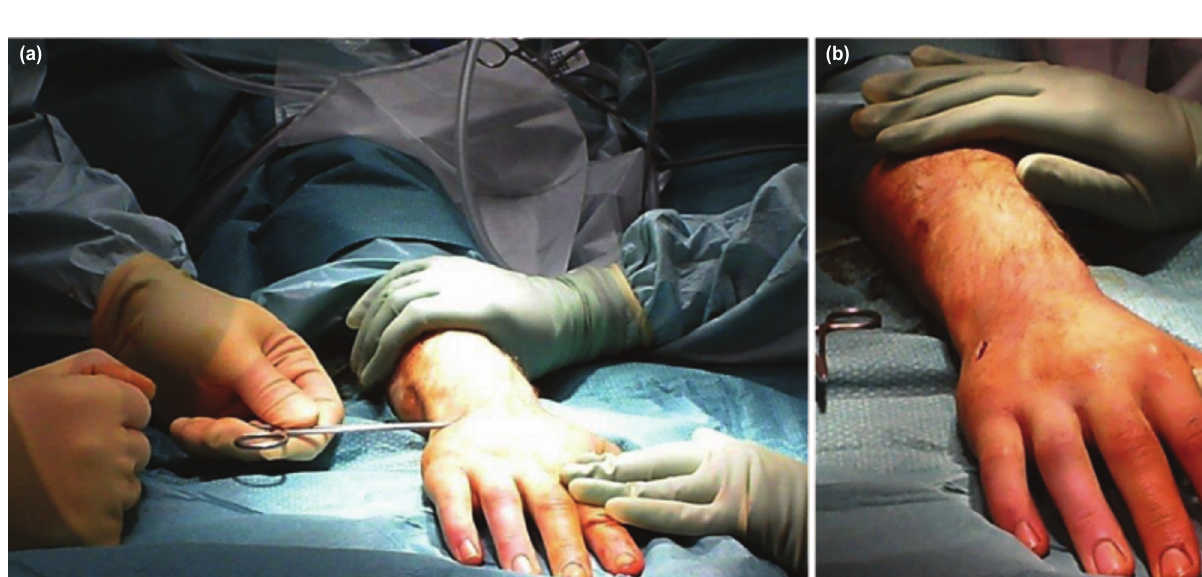
(a) Fluoroscopic guidance is used to confirm reduction by closed manipulation and the entry point is located at the base of the Fig. 1: metacarpal. (b) A small stab incision is made over the entry point and the extensor tendon is retracted. Dissection is performed to expose the dorsal cortex.